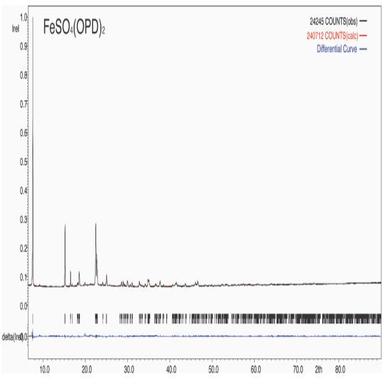
Rietveld refinement plots for 1. The material contains small amount of unidentified impurity characterized weak peaks with d-spacings of 9.6 Å, Å, 4.5 Å, and 4.52 Å.